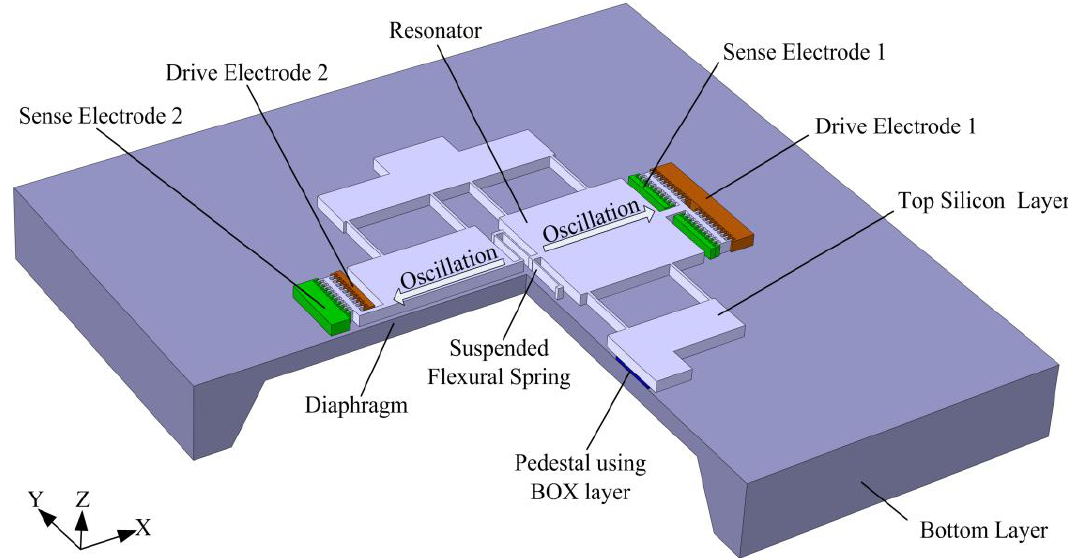
Figure 1. Schematic drawing of the resonant pressure